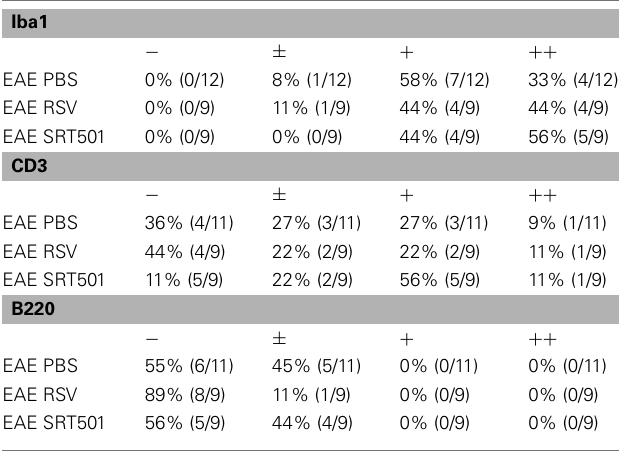
B220 + B cells detected in EAE spinal cords.